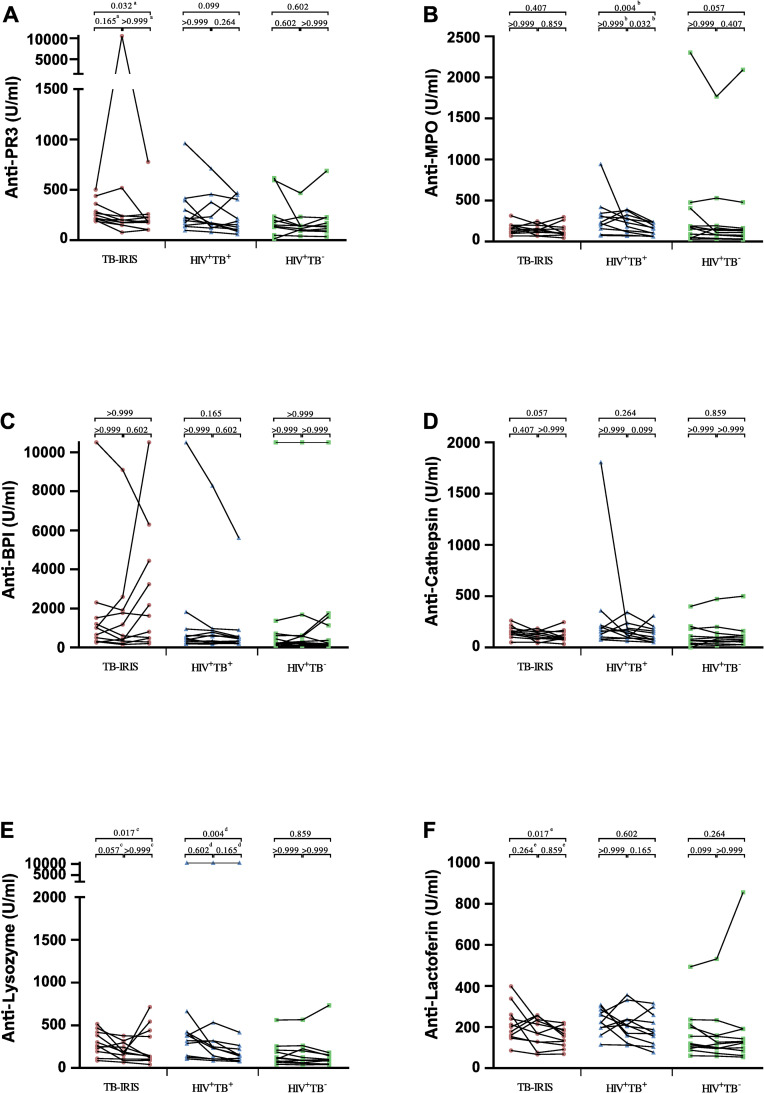
Plasma levels of other ANCAs over time in TB-IRIS patients and controls.Graphs show changes over time for individual patients in the median plasma levels of anti- PR3 (A), -MPO (B), -BPI (C), -cathepsin (D), -lysozyme (E), and -lactoferrin (F) (U/ml) measured prior to ART, and at 3 months and 9 months of ART. Significant variation over time in TB-IRIS patients (red circles), HIV+TB+ (blue triangles), and HIV+TB- (green squares) controls was calculated for each group using Friedman tests, with Dunn’s post-hoc test shown as capped lines to highlight specific differences between individual time points. Out of 17 TB-IRIS patients with samples available pre-ART, only 11 had samples available at both month 3 and month 9. The total number of patients analysed over time was thus 11 for each group. No variation over time was calculated for HIV-TB- controls, since only 1 time point was available. Analysis were performed between all groups at each time point, and between every time points for each group with the level of significance was set to P < 0.05. Overall Friedman p-values were ap = 0.027, bp = 0.002, cp = 0.011, dp = 0.002, ep = 0.019.